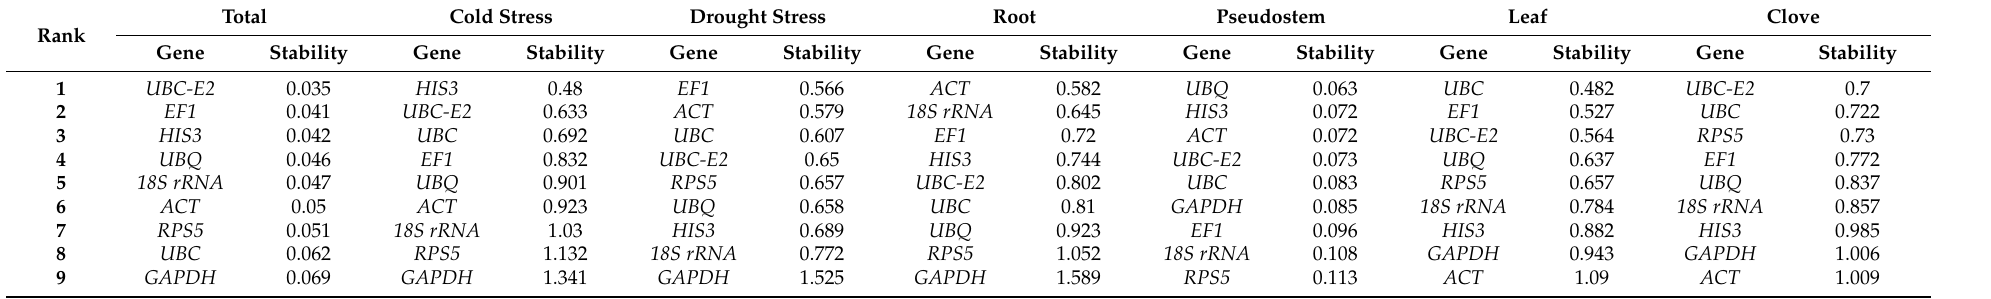
Table 2. Stable values of nine candidate reference genes in different treatments and tissues by NormFinder.